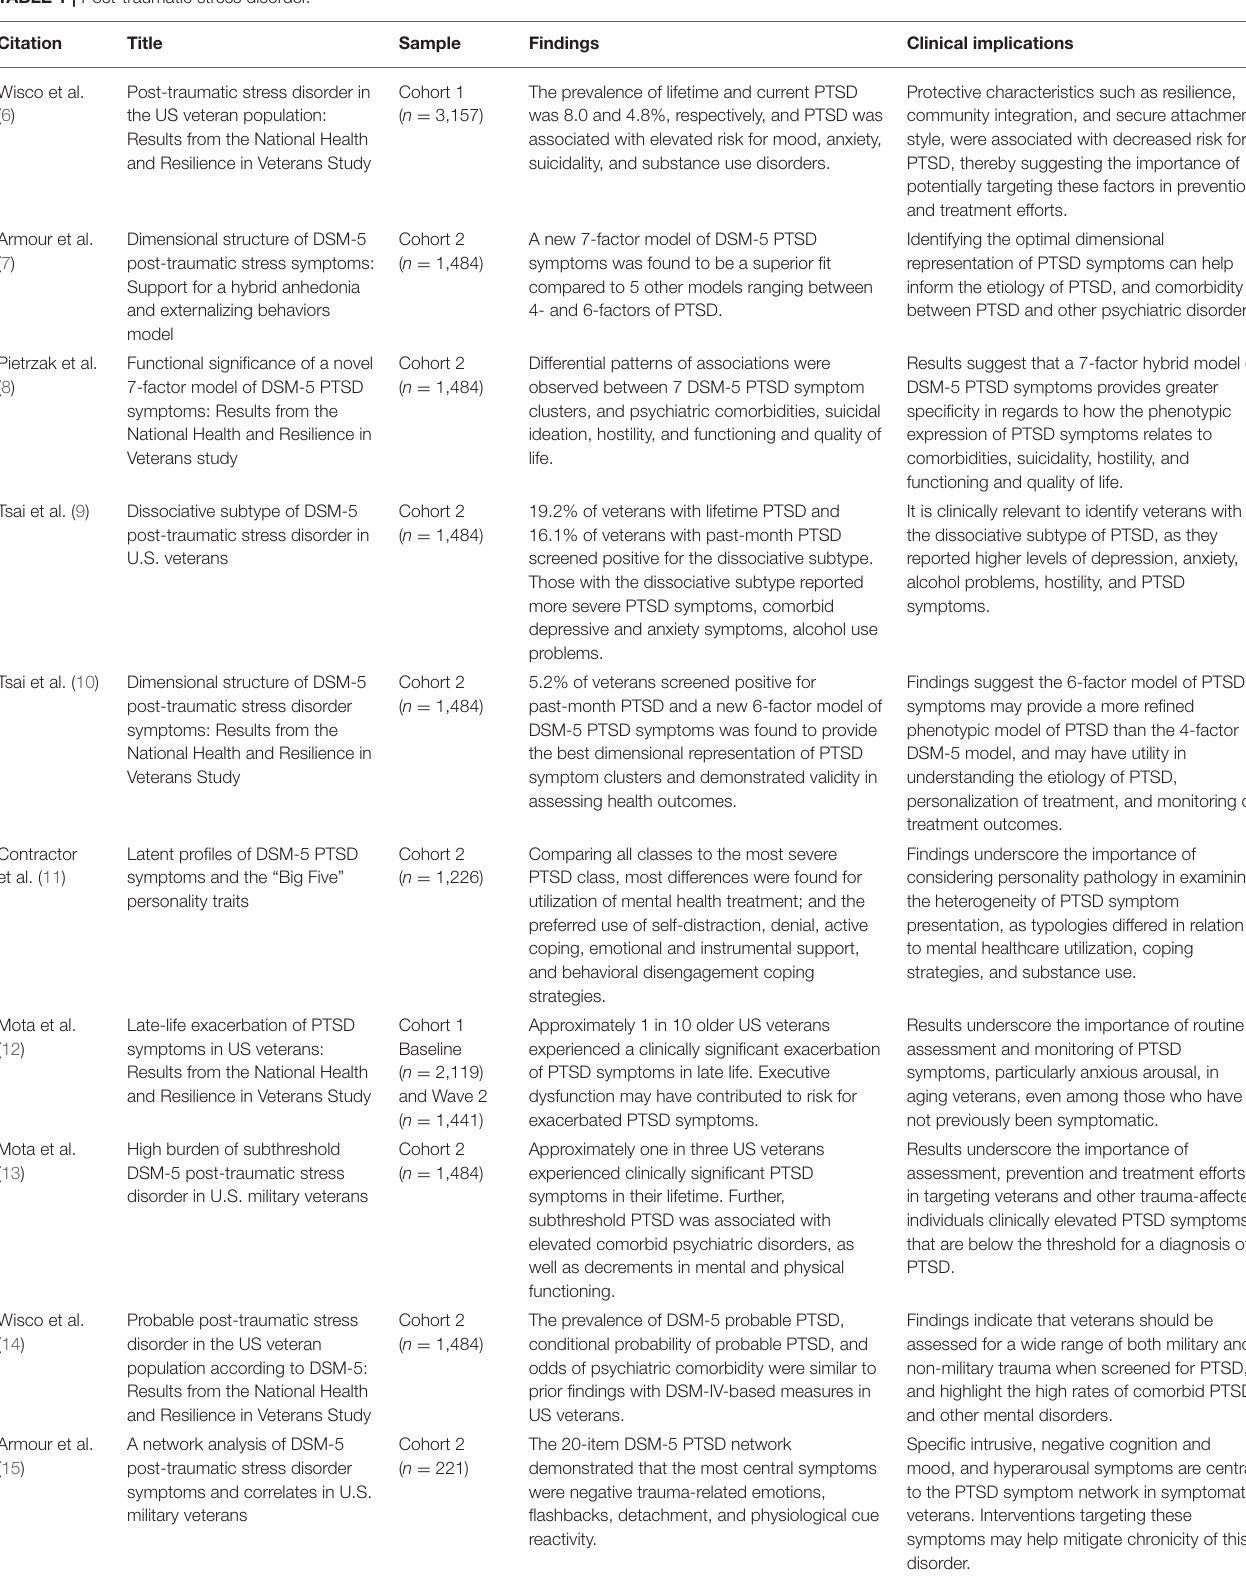
TABLE 1 | Post-traumatic stress